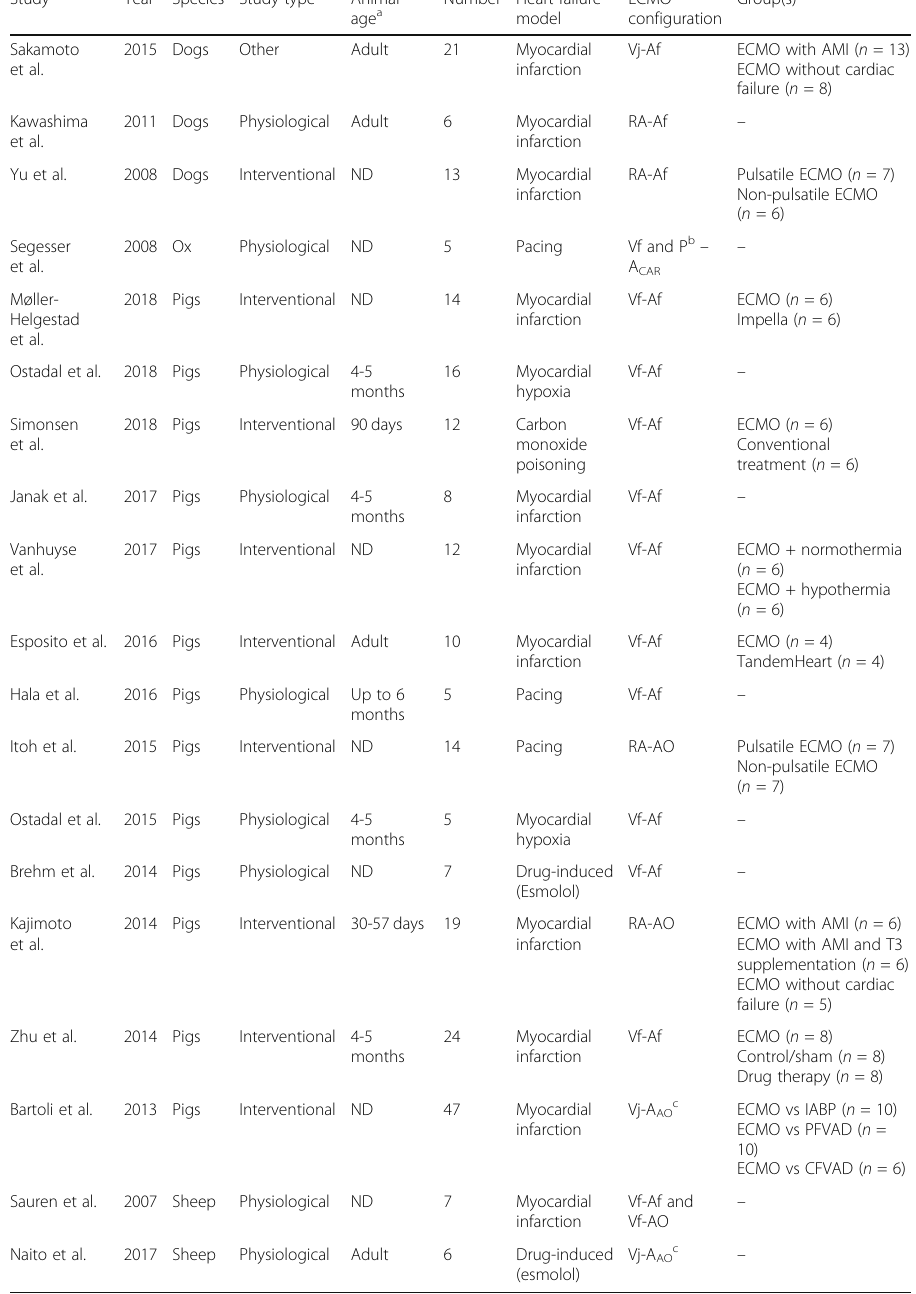
Table 1 Type of studies and main animal characteristics (sorted by animal type)